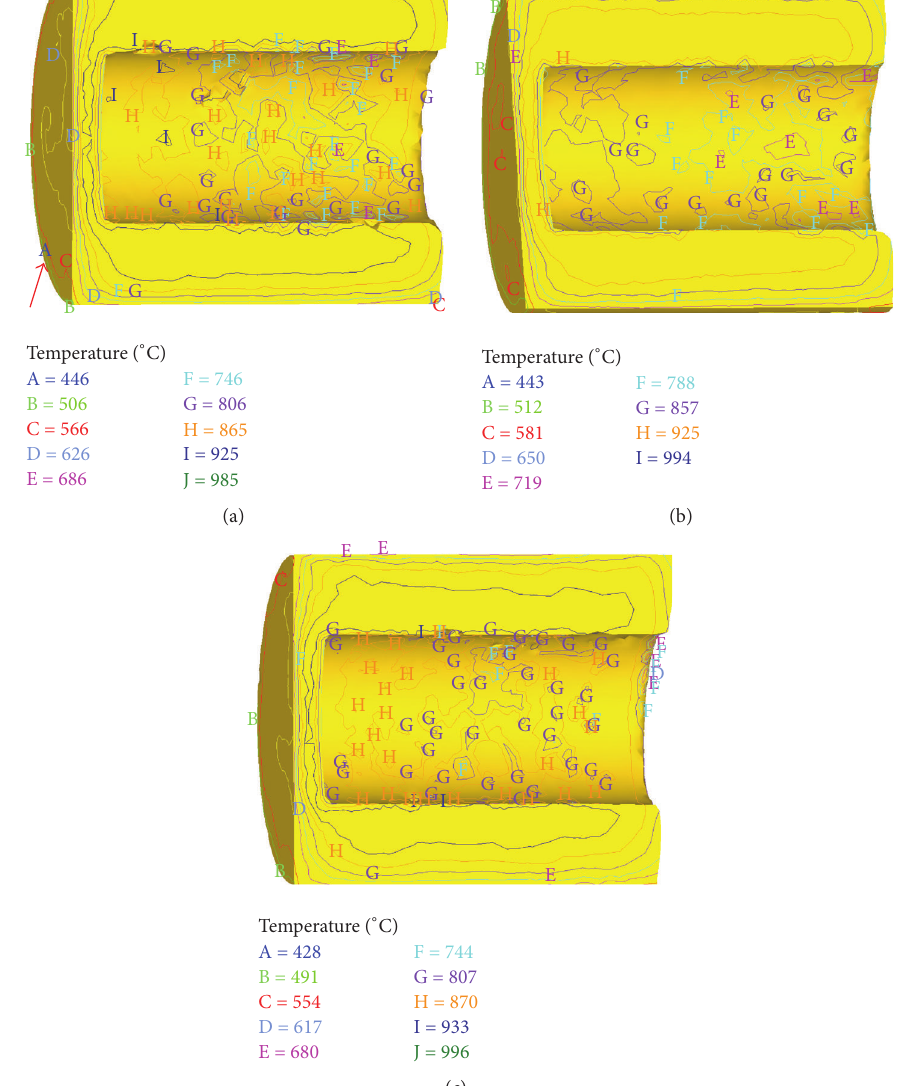
(shown in Figure 9). When the friction coefficient reaches 0.7, the bulge appears at both lower (red arrow) and upper (blue arrow) parts, as shown in Figure